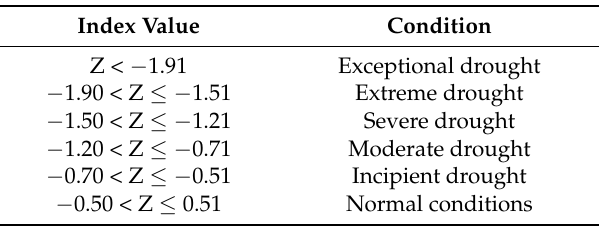
Table 1. Z values vs. drought condition (applicable to both Standardized Precipitation Index and Reconnaissance Drought